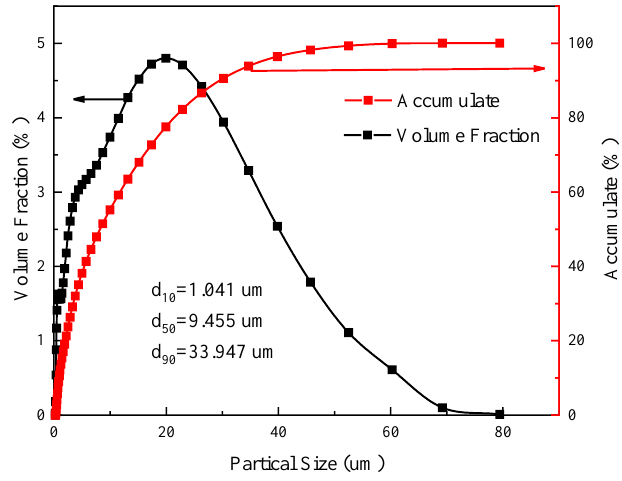
Figure 3. The particle size distribution of the feed sample. Table 1. Multi-element analysis.